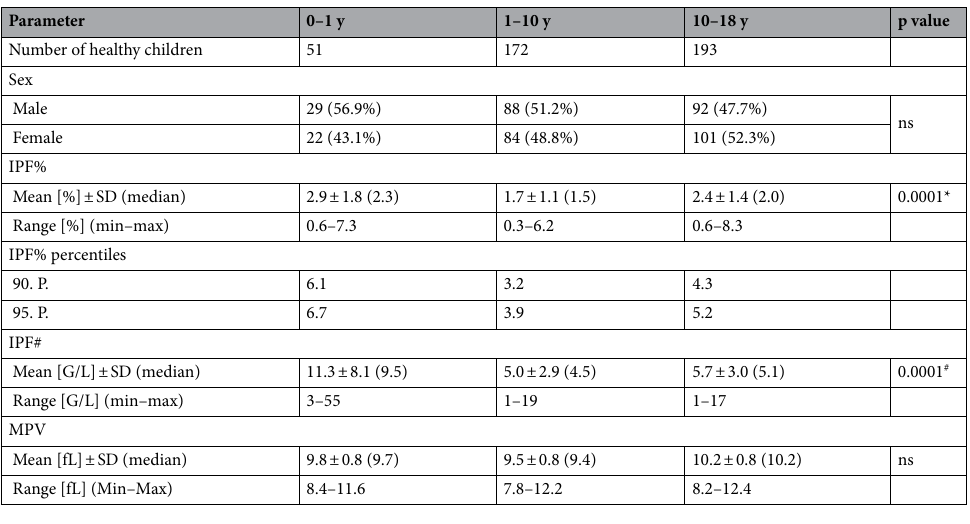
Table 1. Characteristics in a healthy pediatric cohort of 416 patients according to IPF%, IPF# and MPV. IPF%, immature platelet fraction relative; SD, standard deviation; min, minimum; max, maximum; y, years; P., percentile, MPV, mean platelet volume; IPF#, immature platelet fraction absolut; ns, not significant. *p value calculated across all age groups; 1–10 vs 10–18: p 0.0001, 1–10 vs 0–1: p 0.0001, 10–18 vs 0–1: p 0.072. # p value calculated across all age groups; 1–10 vs 10–18: p 0.023, 1–10 vs 0–1: p 0.0001, 10–18 vs 0–1: p